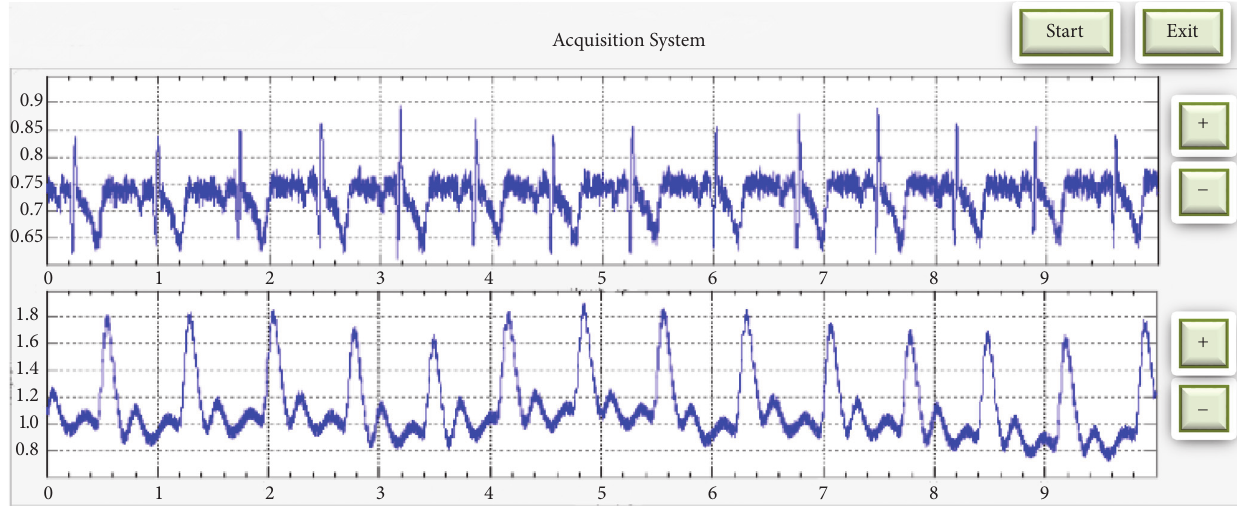
Figure 6: Electrocardiographic spectra that register the cardiac pulse and ECG signal obtained by using the sensor PLZT with Pt wire implanted.